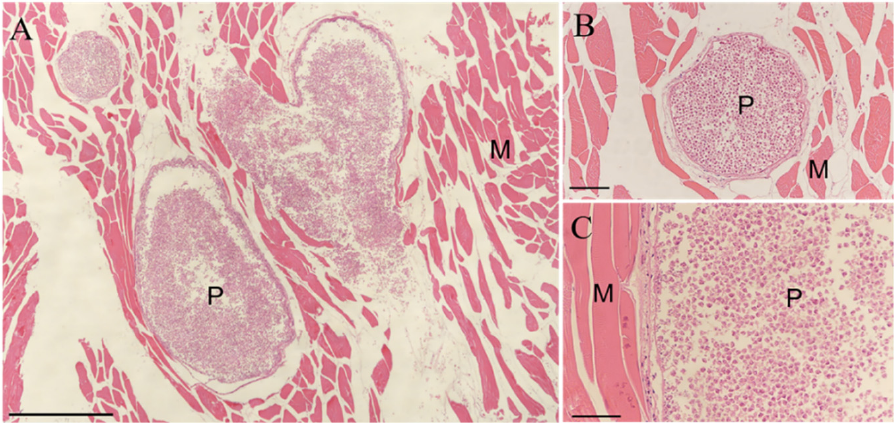
Figure 4. Histological analysis of muscle in large yellow croaker positively infected with Kudoa. H&E staining: ( A ) Scale bar = 500 µm. ( B ) Scale bar = 100 µm. ( C ) Scale bar = 50 µm. P, parasite; M, muscle.